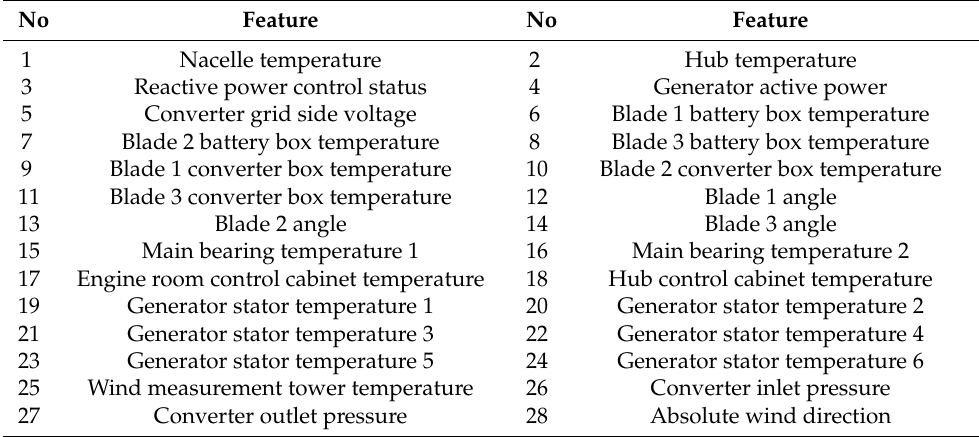
Table 1. Selected SCADA